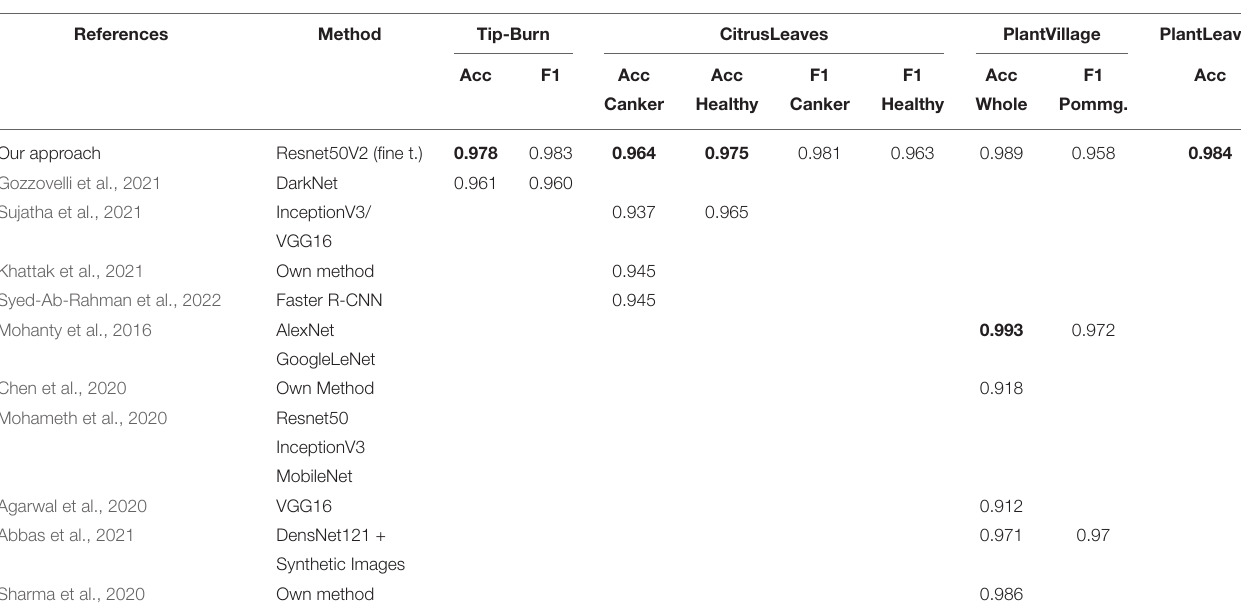
TABLE 1 | Tip-burn stress and plant disease